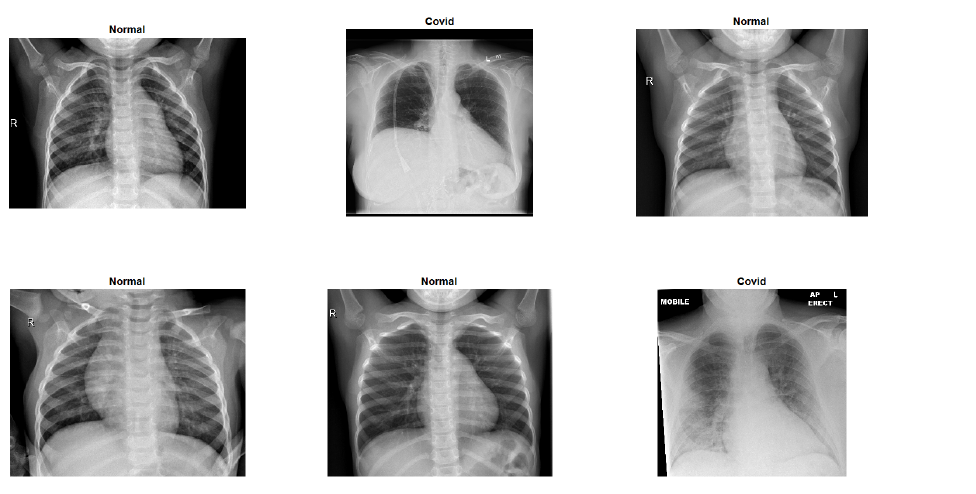
Figure 1. Six random sample images from the COVID-X-ray-5k dataset.